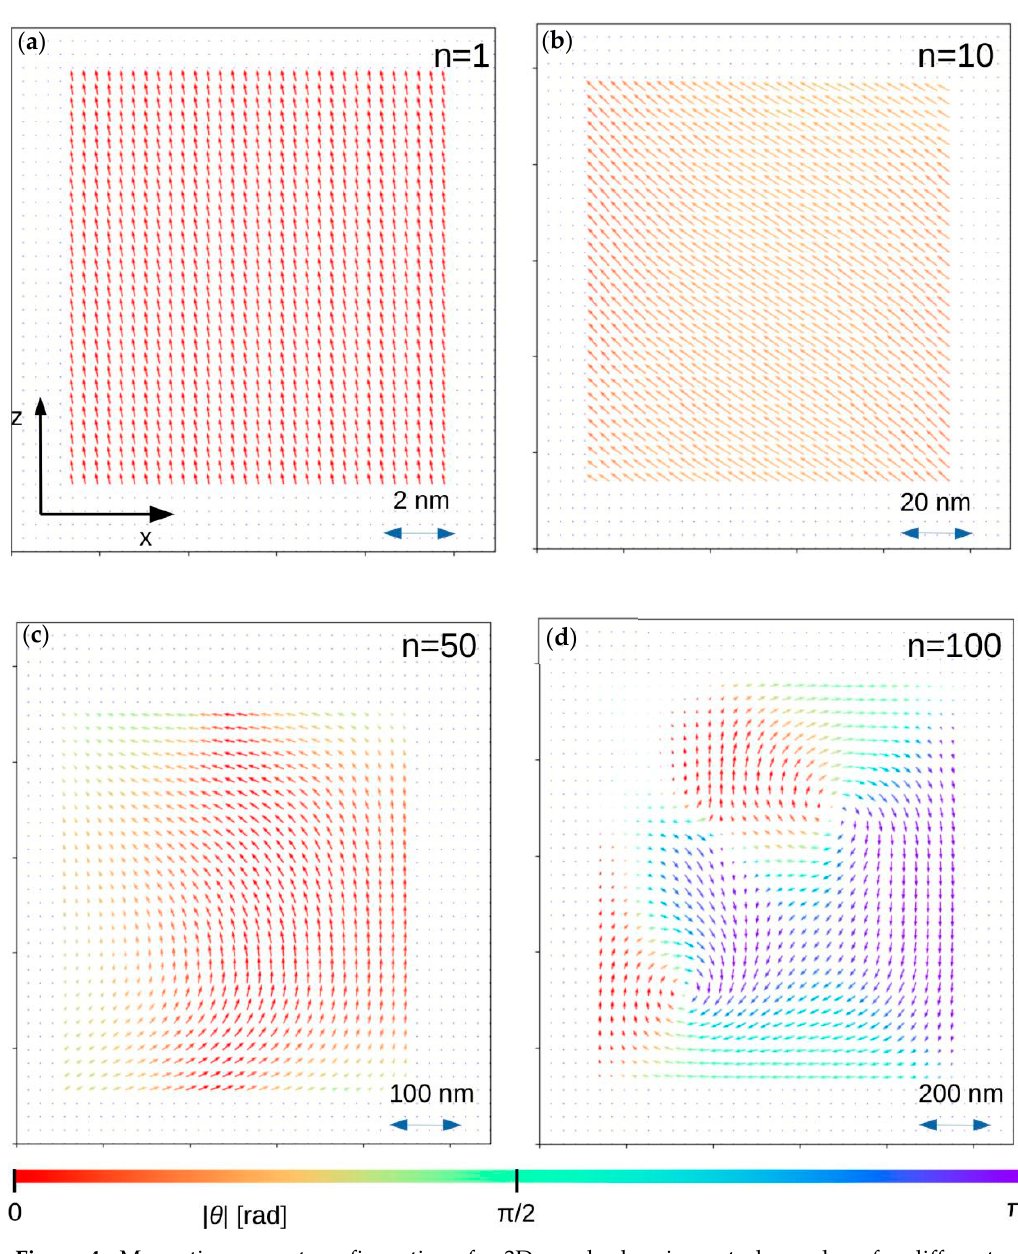
Figure 4. Magnetic moment configurations for 3D regular box in central z-x plane for different n parameters. In this figure, θ is the angle between magnetic moment direction and the z-axis . ( a ) n = 1; ( b ) n = 10; ( c ) n = 20; ( d ) n = 100.